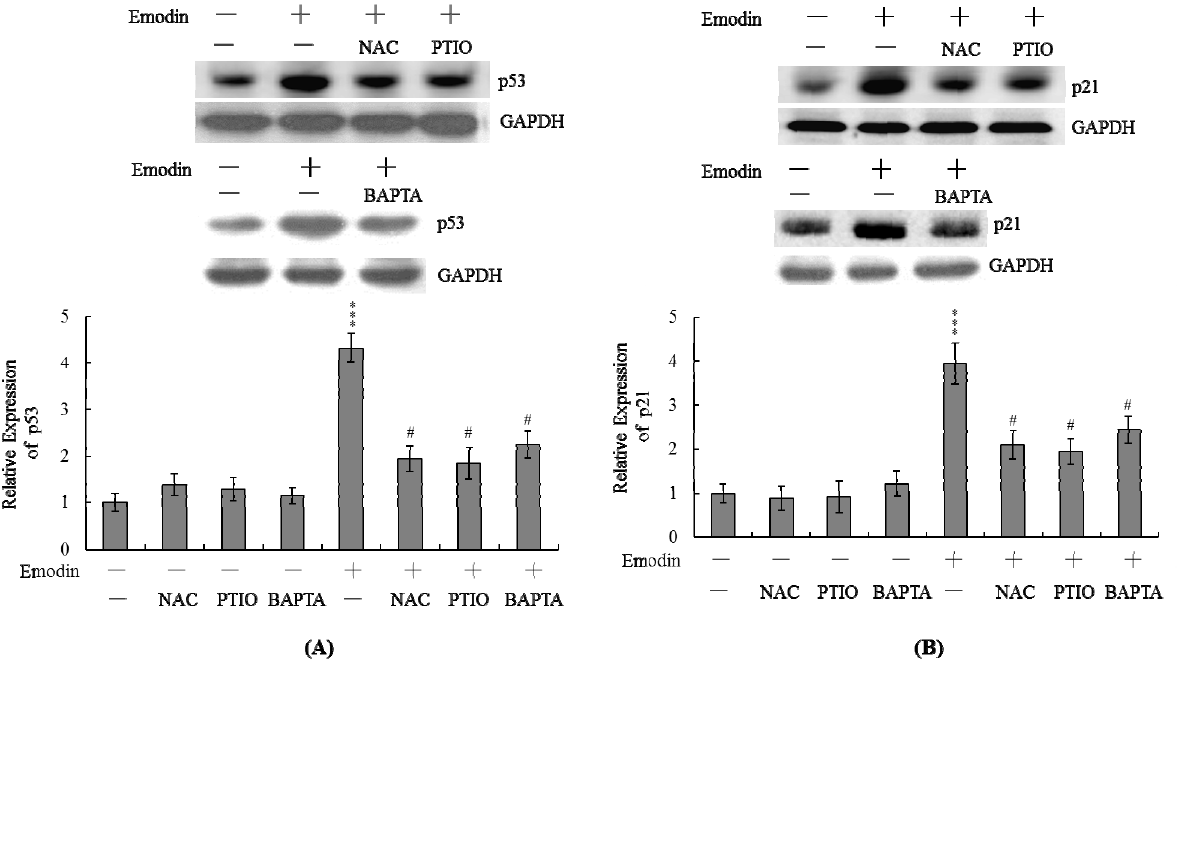
Figure 5. Effects of NAC and PTIO on p53 and p21 mRNA levels. IMR-32 cells were either pre-incubated with NAC (300 μ M), PTIO (20 μ M) or BAPTA-AM (BAPTA; 10 μ M) for 1 h or left untreated, followed by treatment with 20 μ M emodin for another 24 h. The mRNA levels of p53 ( A ) and p21 ( B ) were analyzed using real-time PCR. Quantification and agarose gel electrophoresis data of p53 ( A ) and p21 ( B ) were analyzed using real-time PCR; ( C ) Protein expressions of p53 and p21 were detected by immunoblotting. Values are representative of eight determinations. *** p < 0.001 versus the untreated control group. # p < 0.001 versus the “emodin-treated”